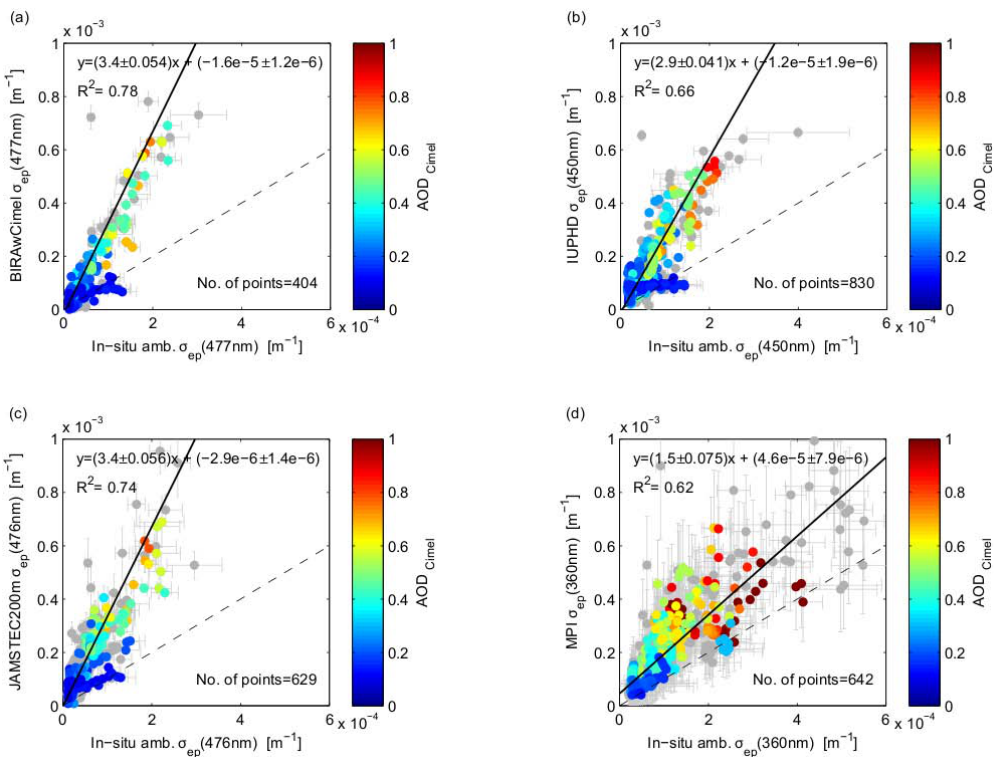
Fig. 18. Ambient aerosol extinction coefficient retrieved from MAX-DOAS observations versus in-situ measurements brought to ambient conditions. The colour denotes the AOD measured by the Cimel sun photometer (AOD interpolated in accordance with the appropriate wavelength; grey points are times with no sun photometer measurements). The solid black line represents a bivariate linear regression including weights (with calculated uncertainty of slope and intercept). The dashed line is the 1:1-line (Fig. 8 from Zieger et al.,